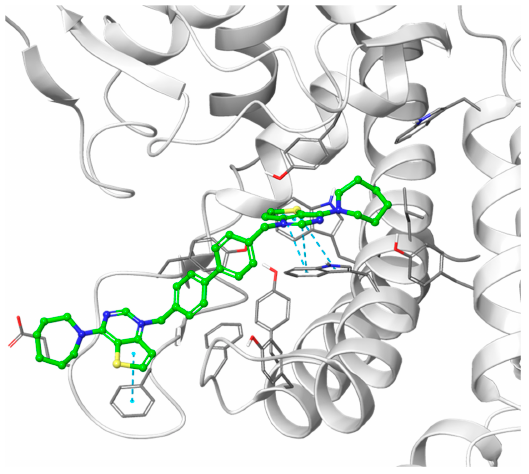
Figure 6. Hypothetical binding pose of the most potent compound from the biphenyl class, Fa-22 (shown in green), into the 4CG8 crystal structure. π - π stacking interactions are highlighted as dashed cyan